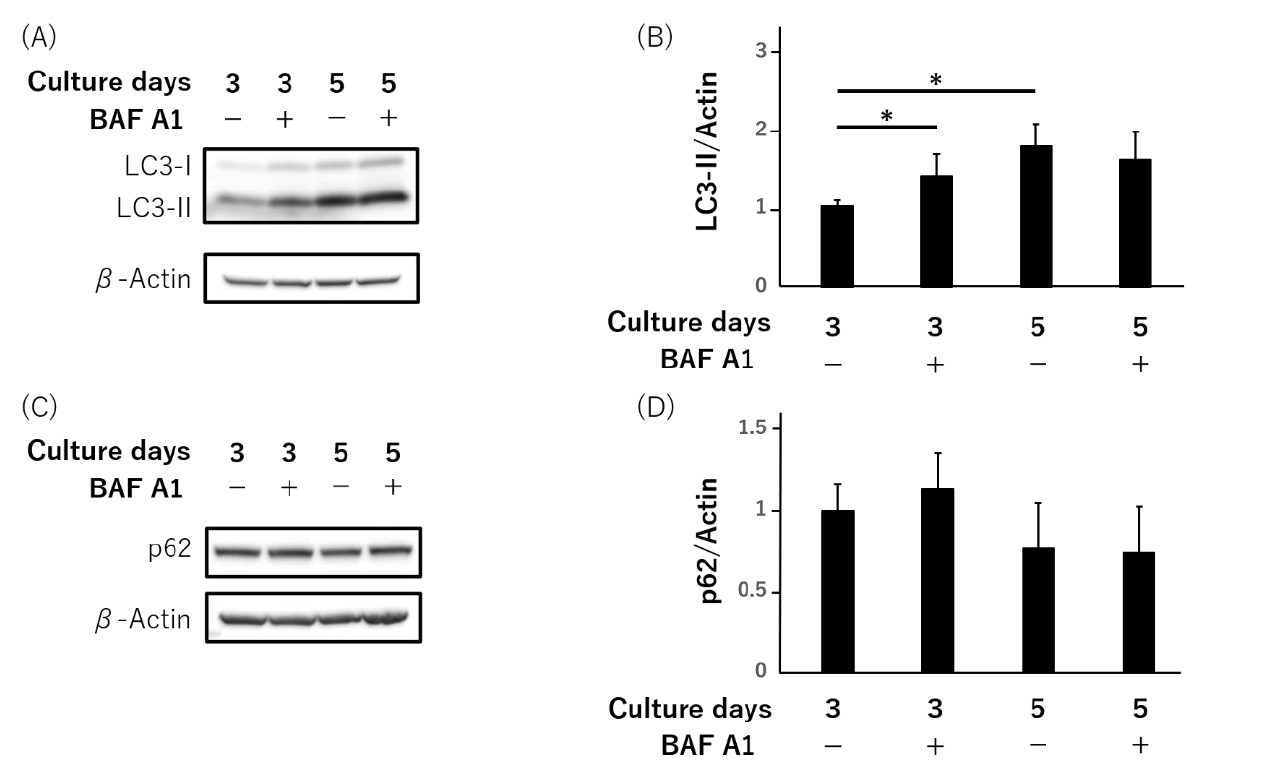
Figure 1. Differentiation and autophagy flux in primary human trophoblasts (PHT). PHT were cul- tured for 3 and 5 days to induce syncytialization. The cells were treated with or without Bafilomycin A1 (BAF A1, 20 nM) for 24 h to confirm autophagic flux. The protein levels were detected by Western blotting ( A , C ), and protein quantification was calculated using Image J ( B , D ). Protein expression of LC3-II was used for an autophagosomal marker ( A ). The graph showed the quantified protein levels of LC3-II ( B ). p62 was a substrate of autophagosome ( C ), and the graph showed the expression levels of p62 ( D ). The graphs were obtained from the three independent results. A significance test was performed: * p < 0.05.